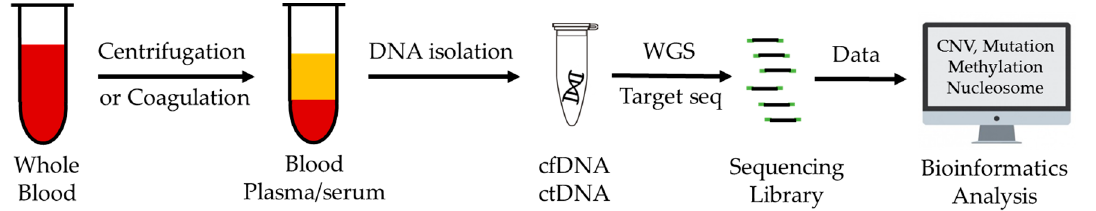
Figure 1. Workflow of blood-based liquid biopsy .